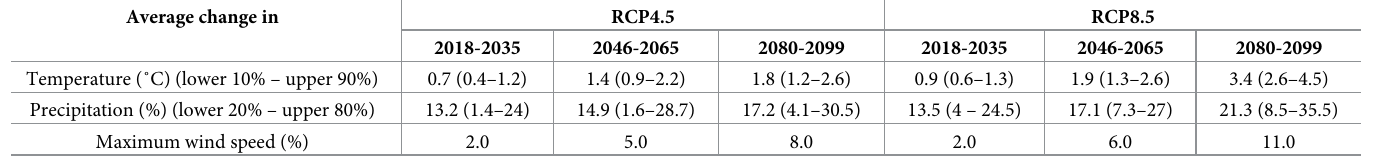
Values in parentheses are confident intervals: lower 10% – upper 90% for temperature; and lower 20% – upper 80% for